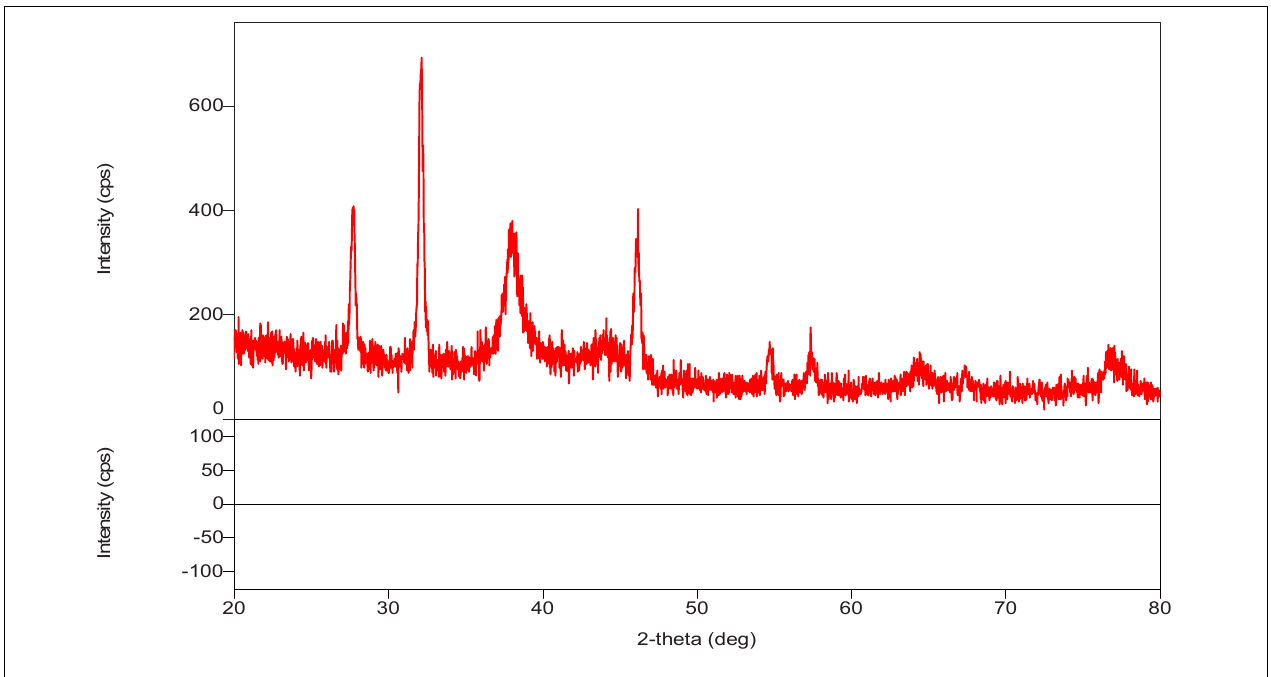
FIGURE 9 | X-ray diffraction (XRD) analysis of silver nanoparticles synthesized from P. variotii